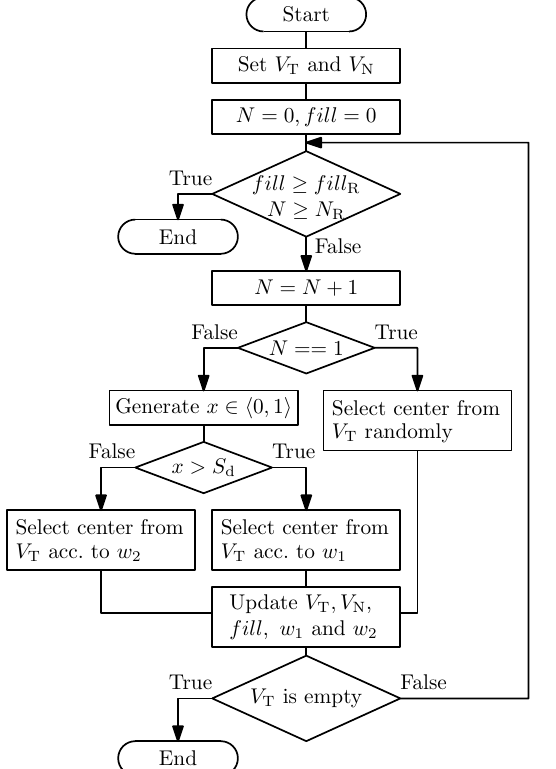
Figure 7. Flowchart of slot-filling function.